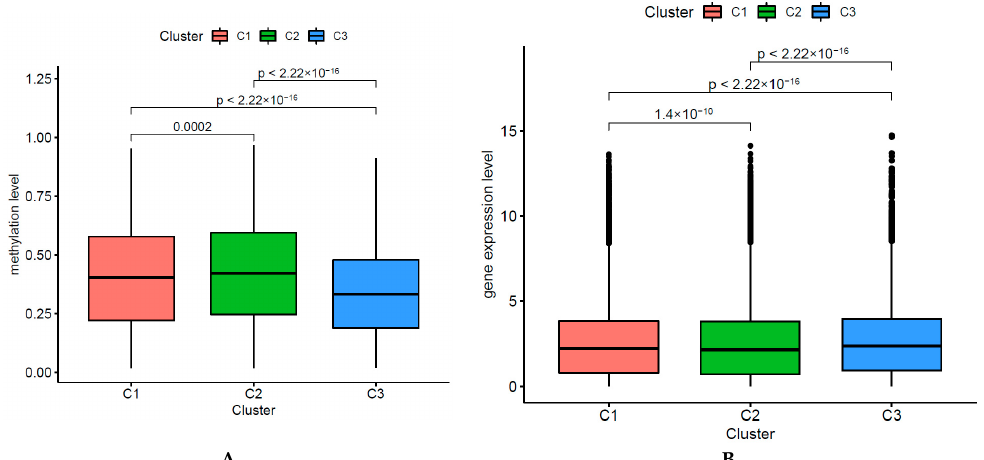
Figure 2. Main clinicopathological significances are different among three subgroups. ( A ) Overall survival curve for each DNA CpGs-pair subtype. ( B – H ) Clinicopathological features (M (metastasis) status, N (nearby lymph nodes) status, T (tumor) status, grade, stage, gender, age) among each DNA CpGs-pair subtype.